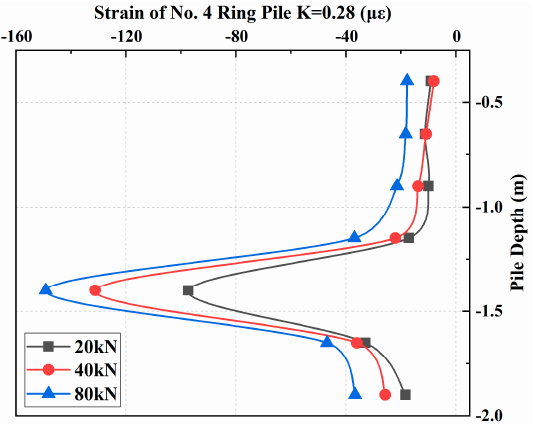
Figure 13. Pile strain of Ring Pile No. 3.